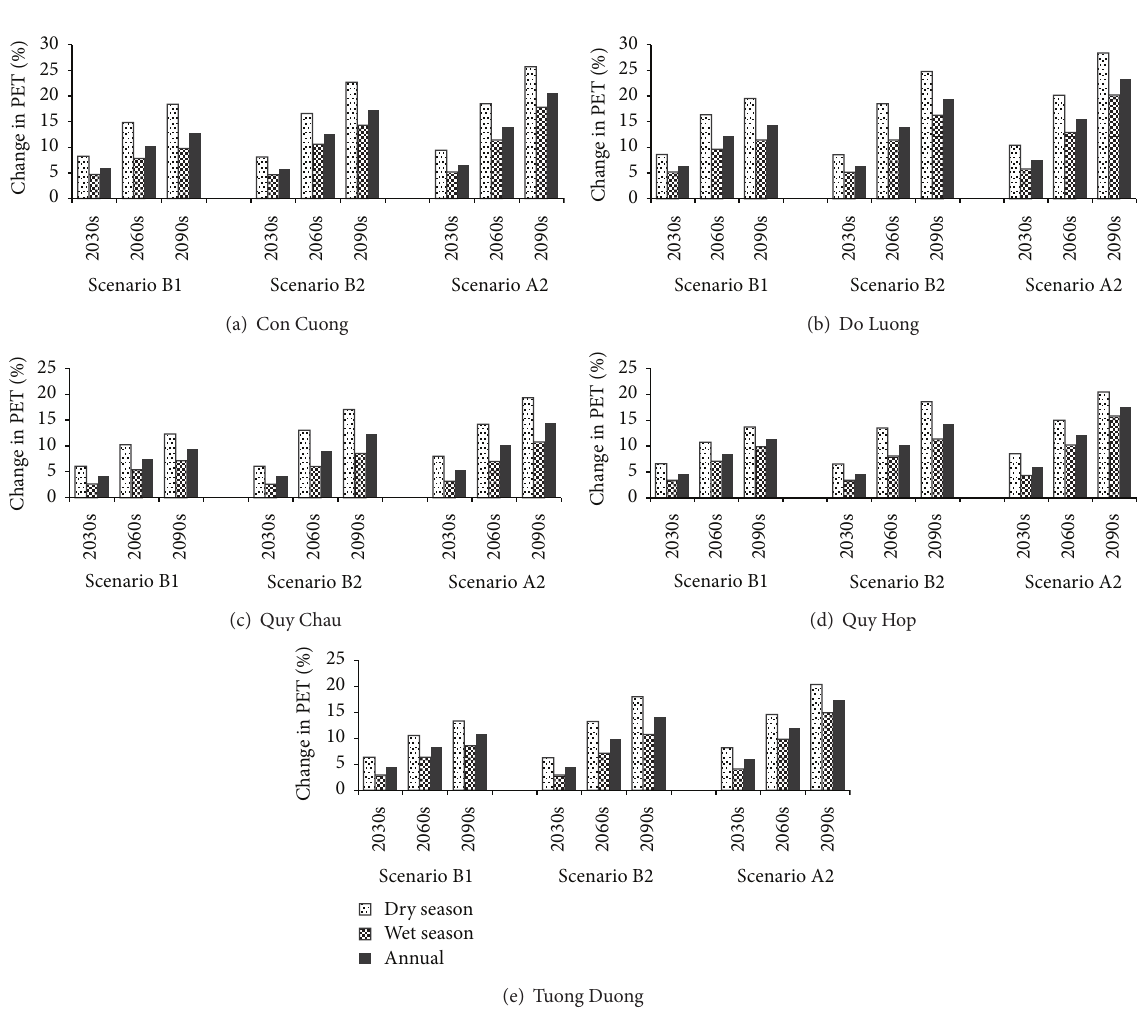
Figure 6: Relative change of PET under three emission scenarios at five stations of the UCRW.